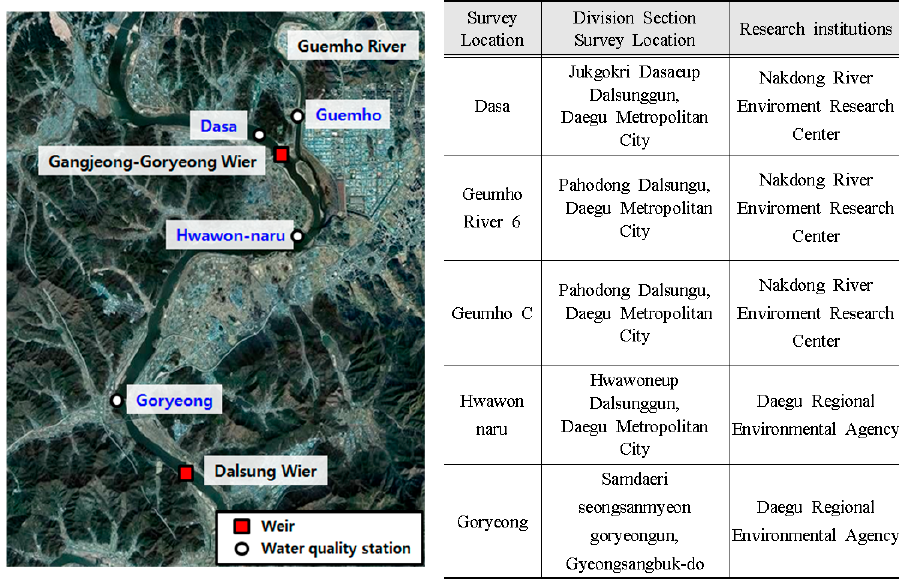
Figure 4. Survey Location of Water Quality Gangjeong-Goryeong Weir and Dalseong Weir Section .